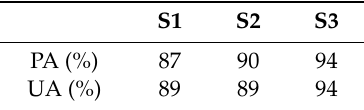
Figure 3. The F1-score of each classification map derived from Sentinel-1 SAR imagery (S1), Sentinel-2 MSI imagery (S2), and a combination of Sentinel-1 and 2 data (S3). Table 5. The producer’s (PA) and user’s (UA) accuracy of Sentinel-1 (S1), Sentinel-2 (S2), and Sentinel-1 / 2 (S3) based mangrove maps.